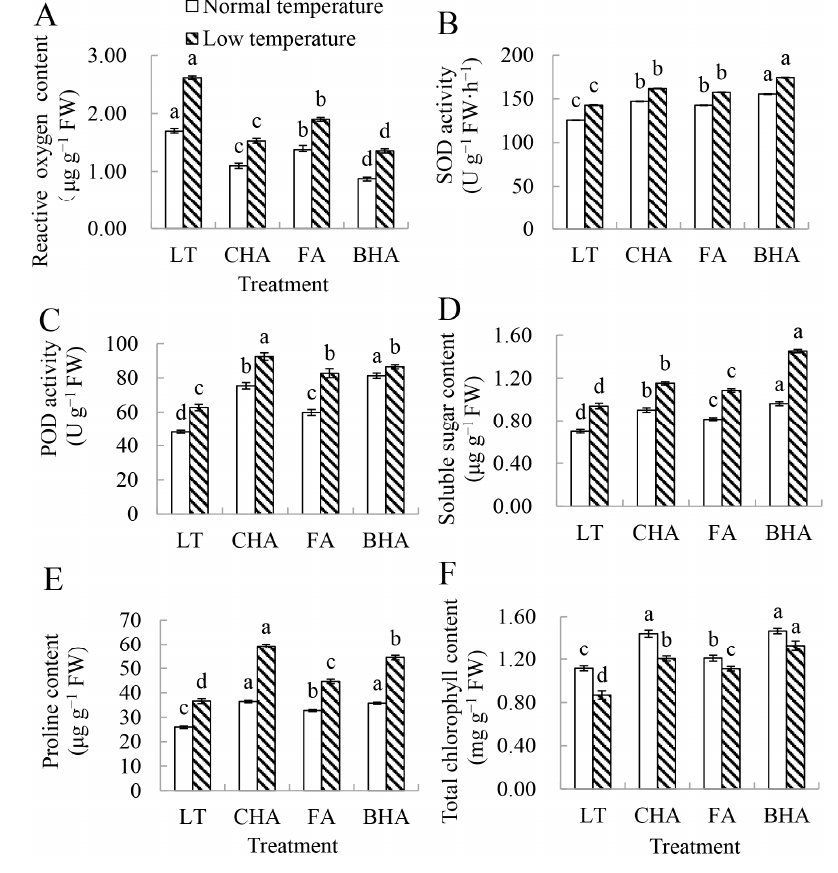
Figure 1. Effects of humic acid treatment on the ( A ) reactive oxygen contents, ( B ) SOD activity, ( C ) POD activity, ( D ) soluble sugar contents, ( E ) proline contents, and ( F ) total chlorophyll contents in zucchini leaves under LT stress ( p < 0.05). LT, 5 ◦ C. CHA, 5 ◦ C + 0.05% coal-based humic acid. FA, 5 ◦ C+ 0.05% fulvic acid. BHA, 5 ◦ C + 0.05% biochemical humic acid. Error bars represented the ±